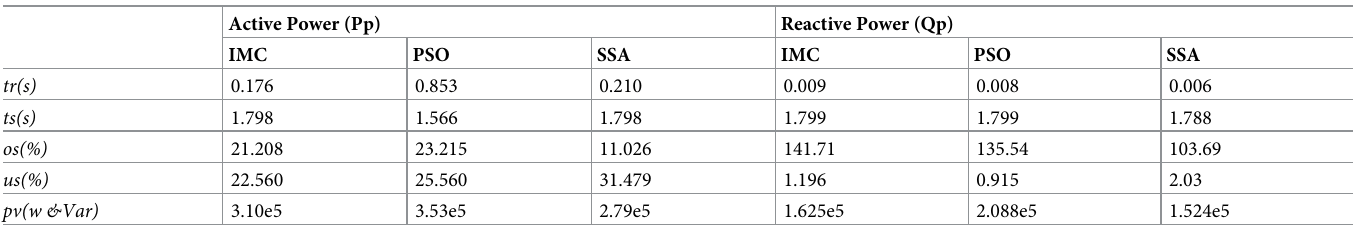
Table 6. Active and reactive power.